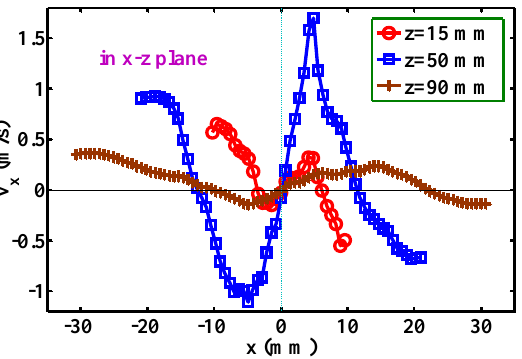
Figure 9. Development of the mean velocity, v z , for positions below the die along ( a ) the x -coordinate and ( b ) the y -coordinate at different z -levels. Positions for ( a ) and ( b ) are in the x-z plane and the y-z plane, respectively.